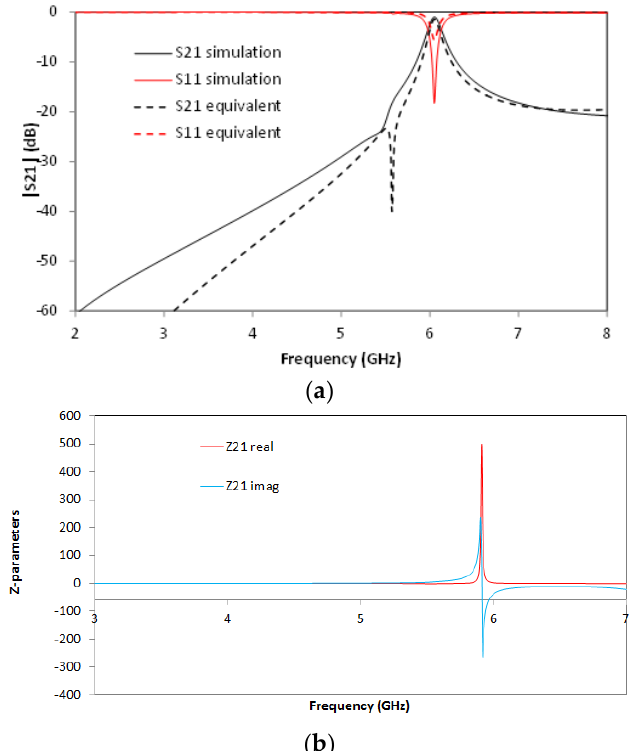
Figure 13. ( a ) Simulated S11 (solid red line), simulated S11 for the equivalent circuit model (dashed red line), simulated S21 (solid black line), simulated S21 for the equivalent circuit model (dashed black line). ( b ) Impedance graph: Z21 real part (solid red line), Z21 imaginary part (solid blue line).